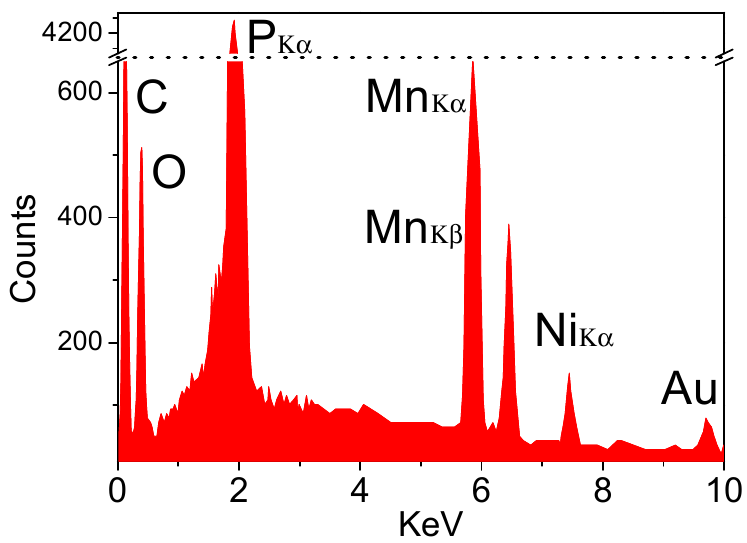
Figure 3. The typical EDX spectrum of the Li(Mn 0.97 ,Ni 0.03 )PO 4 crystal. Table 1. The chemical compositions collected on the three spots on the (001) surface of the Li(Mn 0.95 ,Ni 0.05 )PO 4 crystal. Measurement Spots